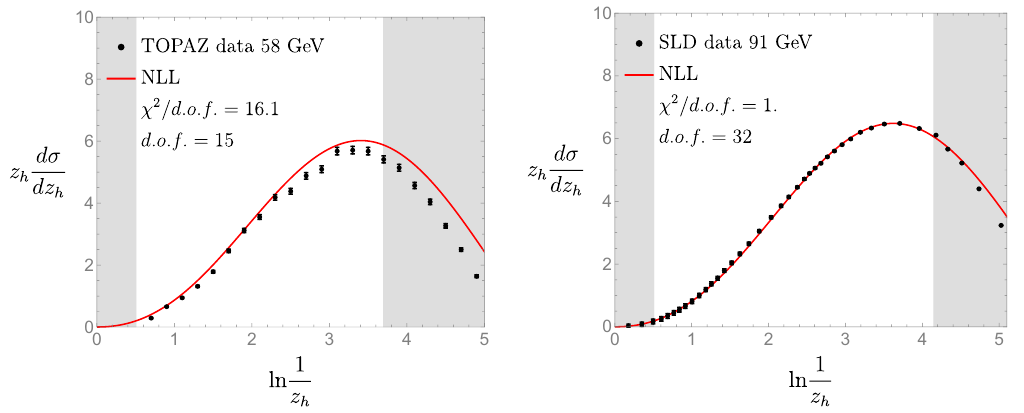
Figure 3 . The fragmentation spectrum for e + e − → h ± + X at center of mass energies 58 and 91 GeV. The gray region is excluded from the χ 2 / d.o.f. determination based on hadron mass cor- rections or z (1) , and the quoted χ 2 / d.o.f. is the goodness-of-fit for that data set alone using h ∼ O